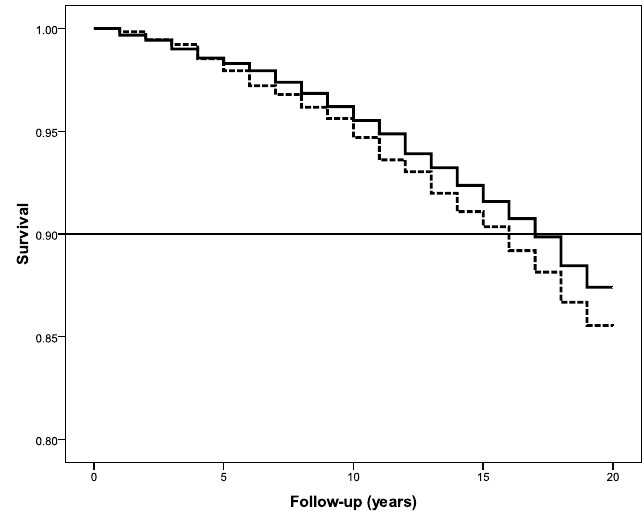
Figure 1. Higher self-acceptance associated with increased survival.